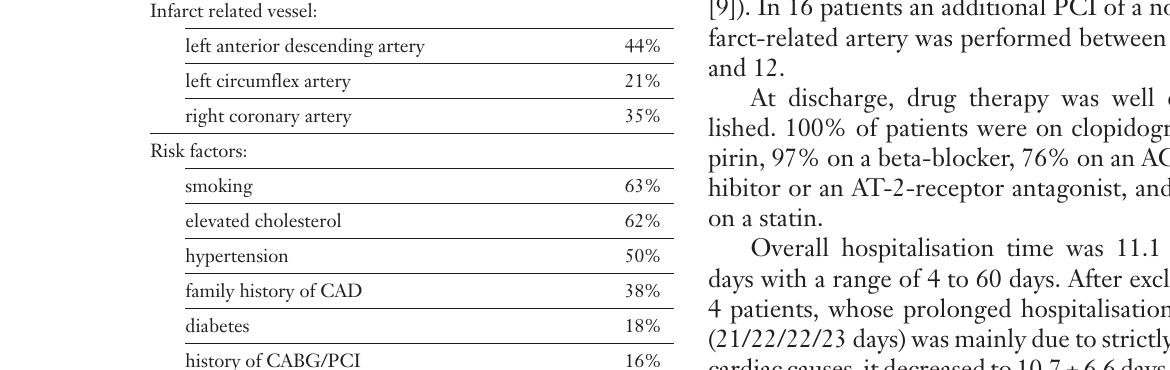
Baseline characteris- tics of